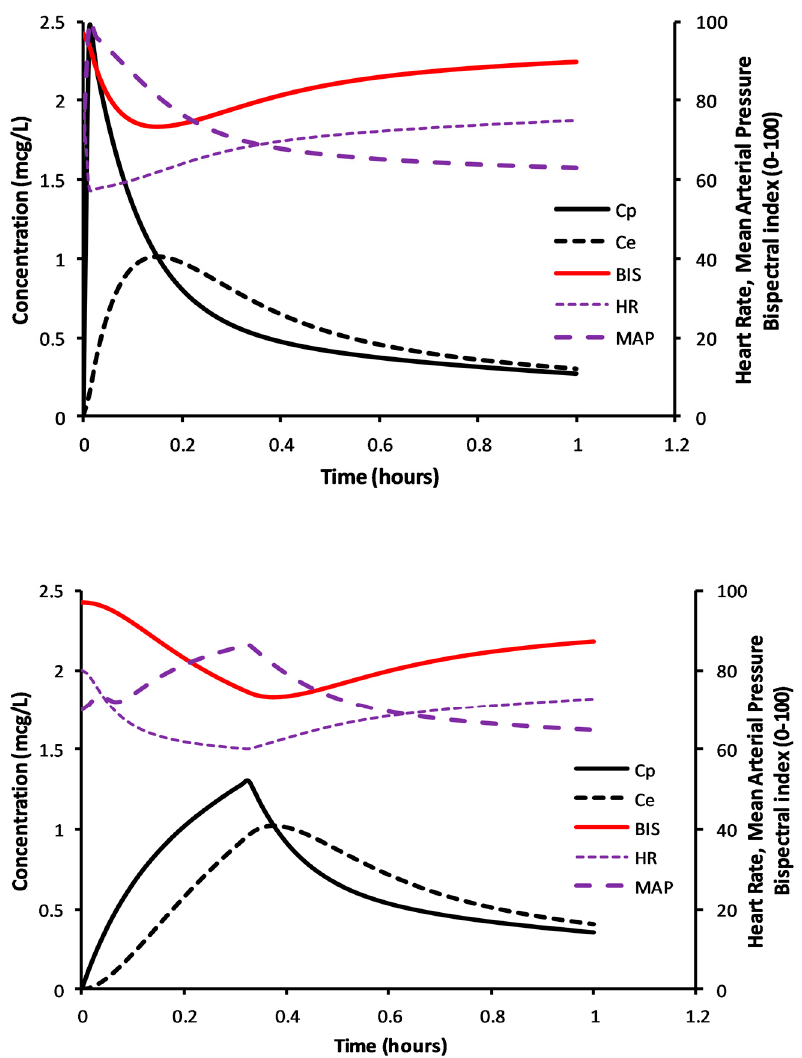
Figure 5. Simulation of hemodynamic adverse effects when dexamethasone is given intravenously to a 6-year-old child (20 kg). Drug in the upper panel was administered as a rapid bolus 0. 9 µg/kg. The lower panel shows hemodynamic changes after a larger loading dose of 1.1 µg/kg delivered as an infusion over 20 min. A similar level of sedation (BIS 73) is achieved at 20 min but the slow infusion is without the dramatic changes in heart rate and mean arterial blood pressure observed after rapid